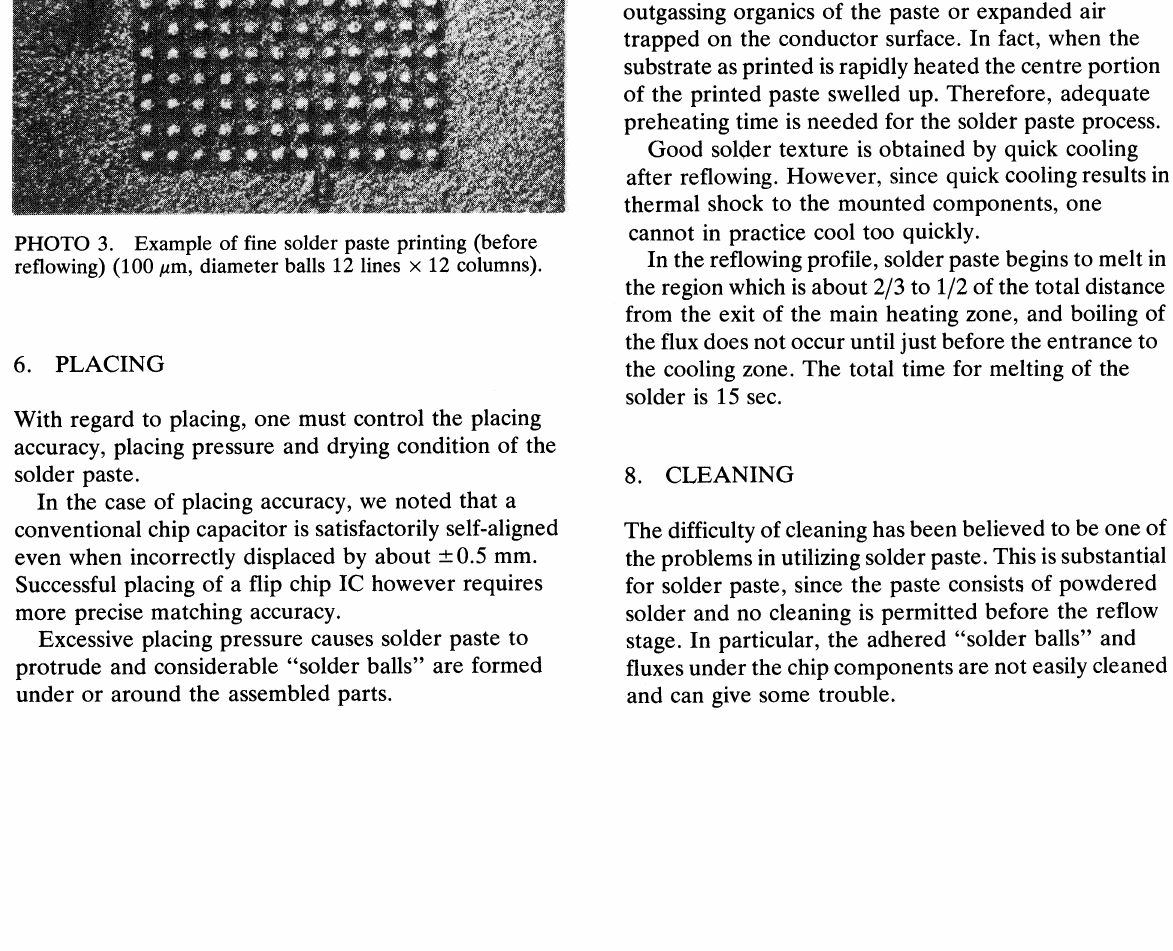
FIGURE 3. Paste thickness vs. snap-off’